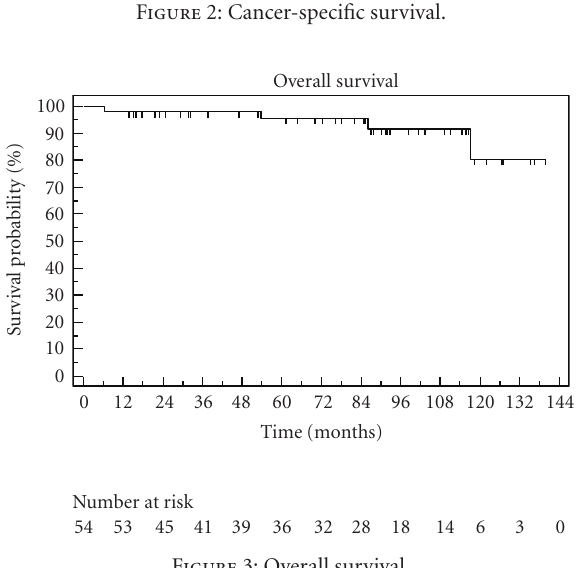
Figure 2: Cancer-specific survival.